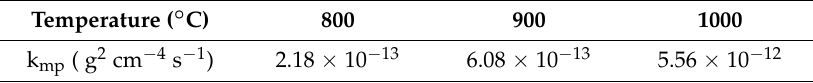
Table 5. The parabolic rate mass parameters that are used in